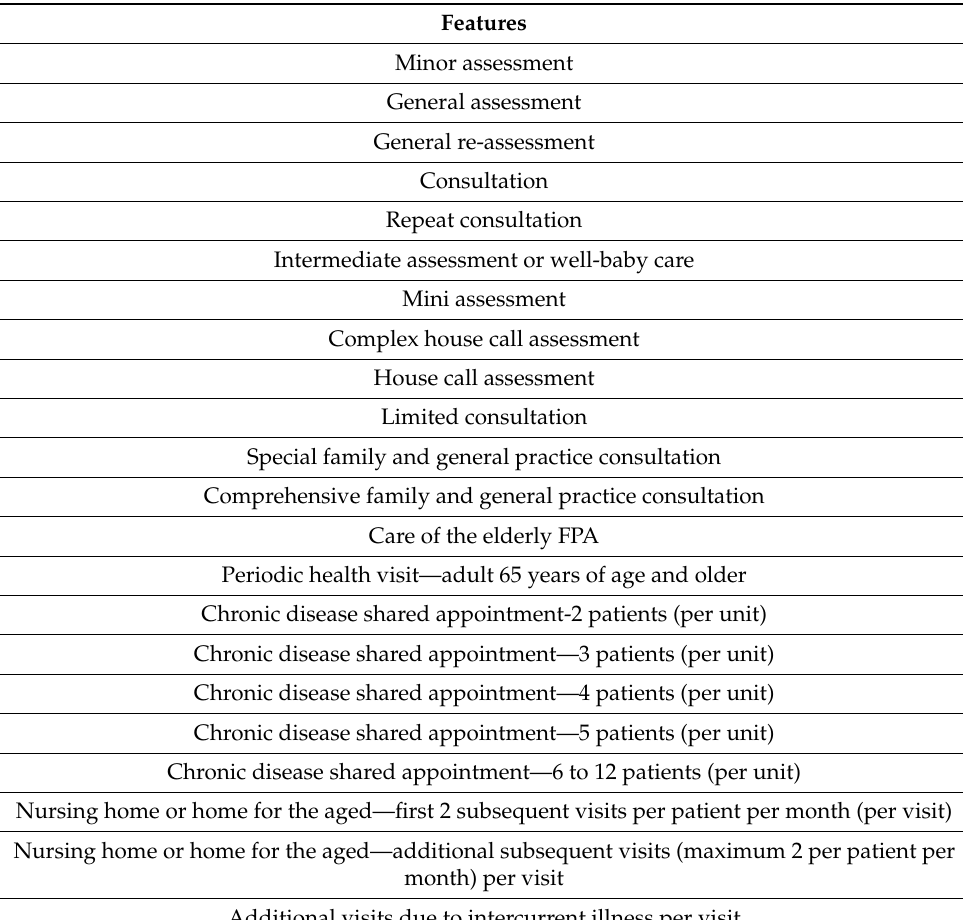
Table 1. The features included in the GP visit Group.